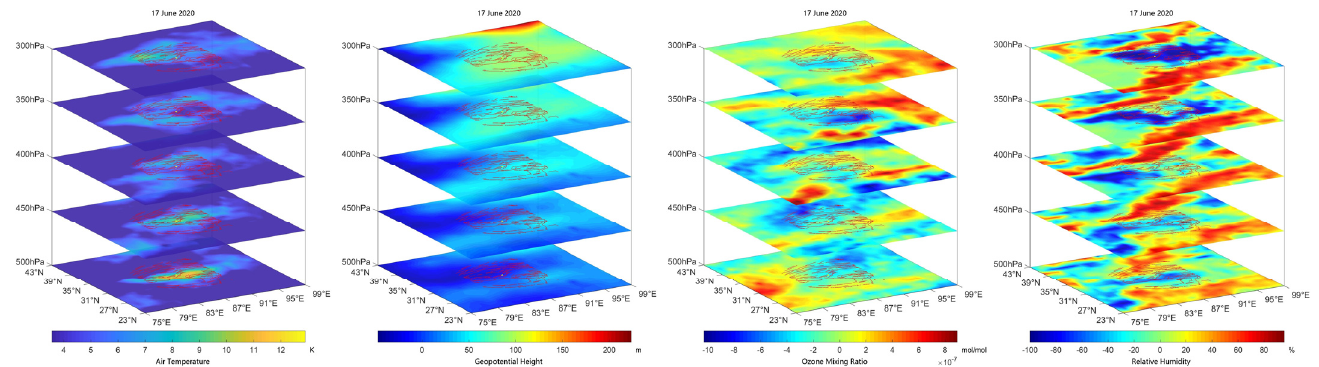
Figure 5. Composite atmospheric anomaly map associated with earthquake in Nima on 17 June. The epicenter and faults are shown by yellow point and red lines, respectively. For each row, the subplots represent air temperature, geopotential height, ozone mixing ratio and relative humidity from left to right.